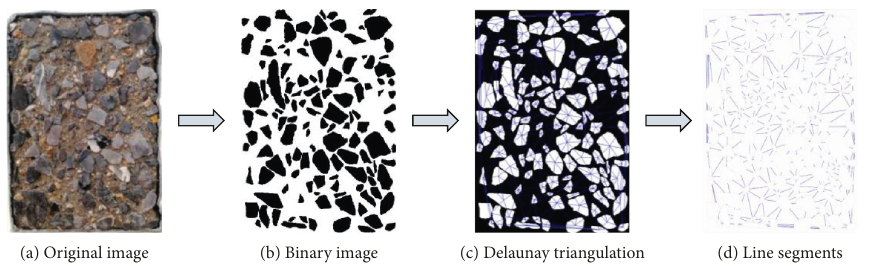
Figure 3: Schematic diagram of the image processing method.